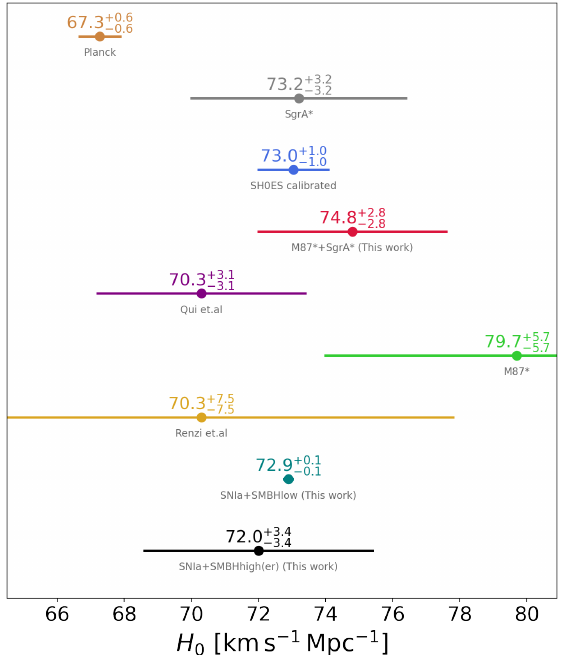
Figure 6. Whisker plot for the H 0 results reported in Table